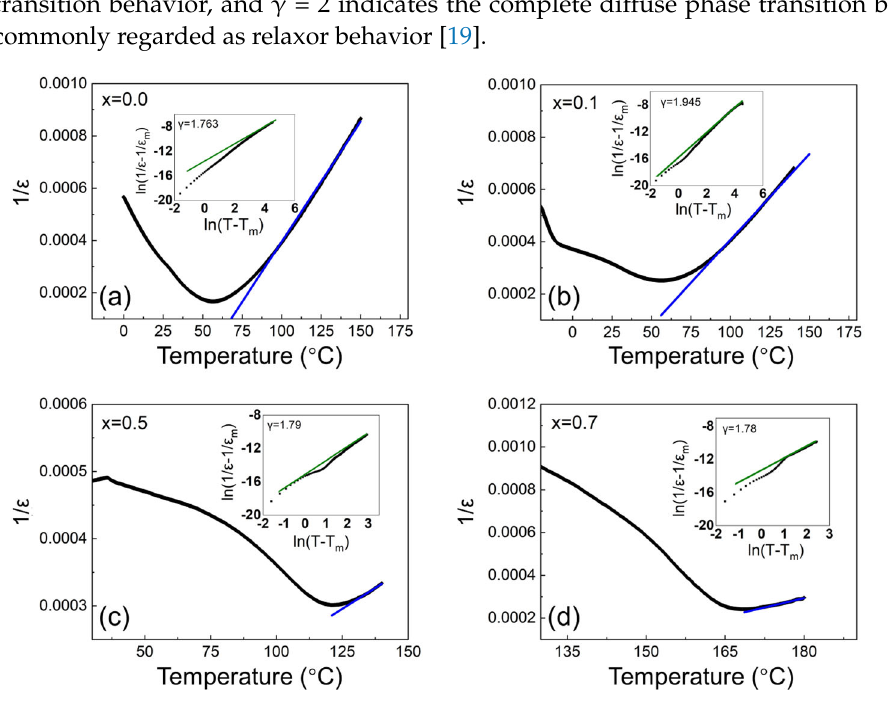
Table 1. The dielectric parameters of BZ 0.18 T–xBP 0.22 T (x = 0.0, 0.1, 0.5, 0.7) at 10 kHz.